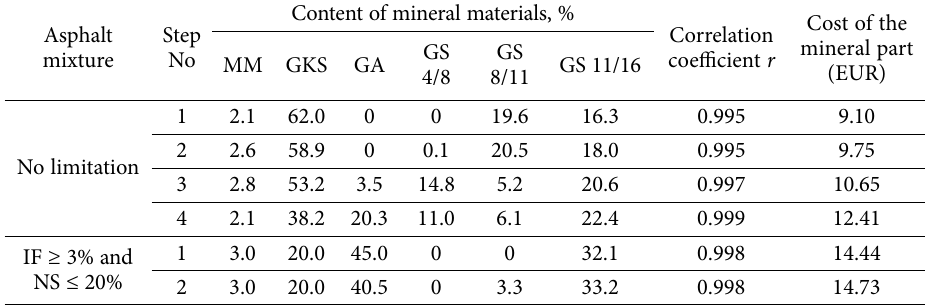
Table 8. The results of calculating the densest gradation of the mineral